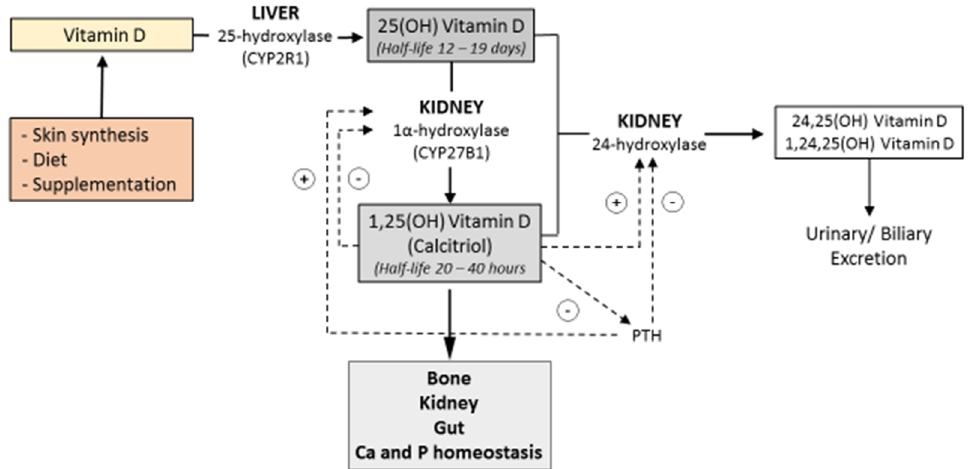
Figure 1. Vitamin D is synthesized in the skin in response to ultraviolet light or provided by the diet. It is first converted to 25-hydroxyvitamin D3 by hydroxylation occurring in the liver and then further converted into its active metabolite, 1,25-dihydroxyvitamin D3, in the kidney. Ca = calcium; P = phosphate; CYP2R1 = Cytochrome P450 Family 2 Subfamily R Member 1; CYP27B1= Cytochrome P450 Family 27 Subfamily B Member 1; 25(OH) vitamin D = 25-hydroxyvitamin D; 1,25 (OH) Vitamin D = 1,25-dihydroxyvitamin D.